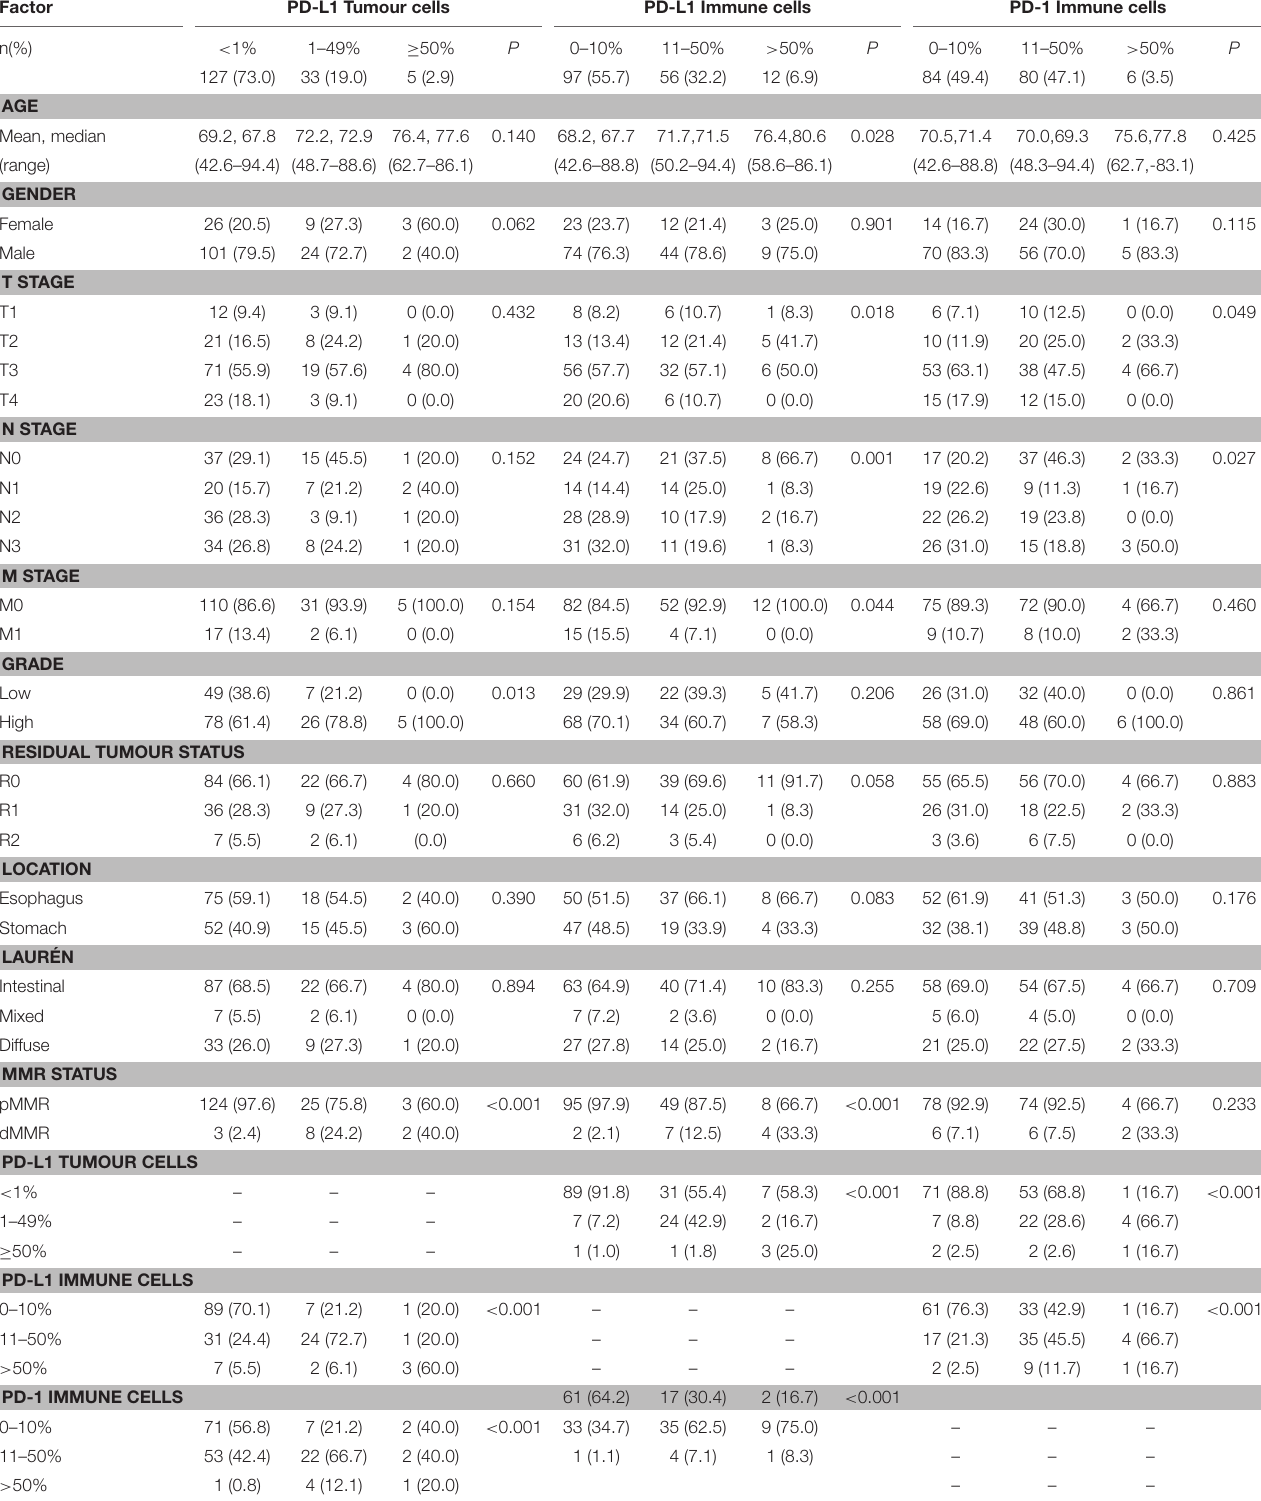
TABLE 1 | Associations with clinicopathological factors and intercorrelation of PD-L1 and PD-1 expression. Factor PD-L1 Tumour cells PD-L1 Immune cells PD-1 Immune